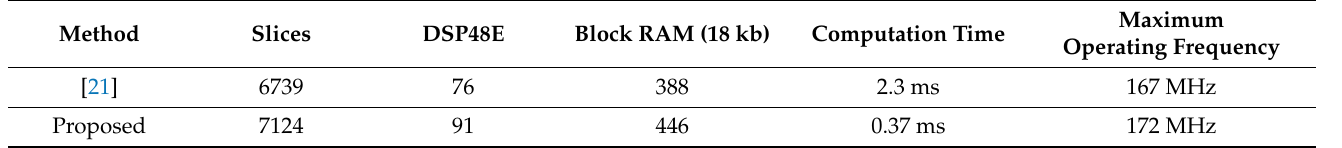
Table 1. Resource usage and performance comparison.